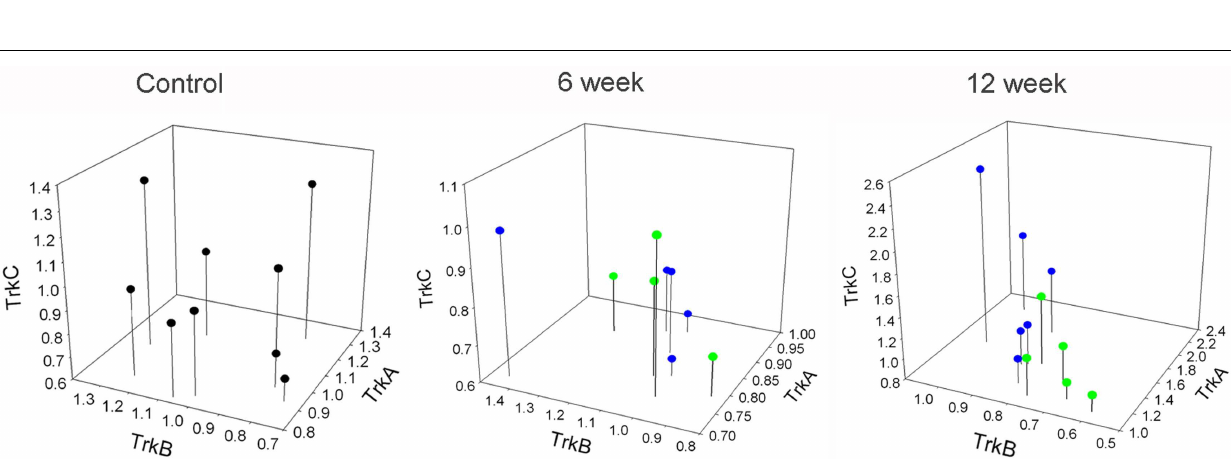
FIGURE 7 | Correlated expression ofTrk receptors in DRG emerges at chronic time points. Values represent fold-change of the individual animals vs. mean of control group. Blue dots represent animals with 12.5gcm injuries. Green dots represent animals with 25gcm